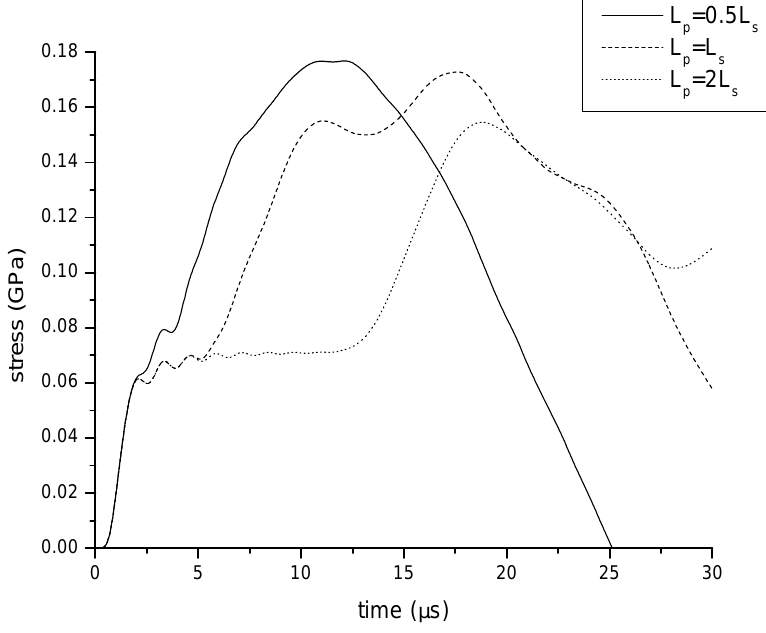
Fig. 7. Stress response in PMMA pad with varied length of PMMA pad (Case